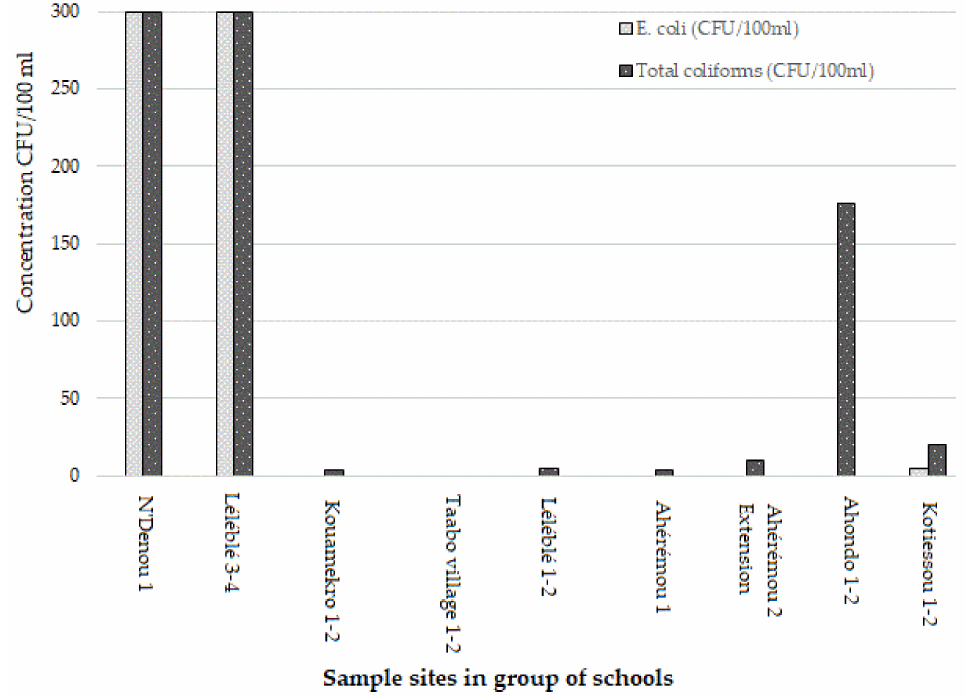
Figure 3. Drinking water quality depicted in colony forming units (CFUs) per 100 mL of E. coli and total coliforms in primary schools of the Taabo HDSS (October–November